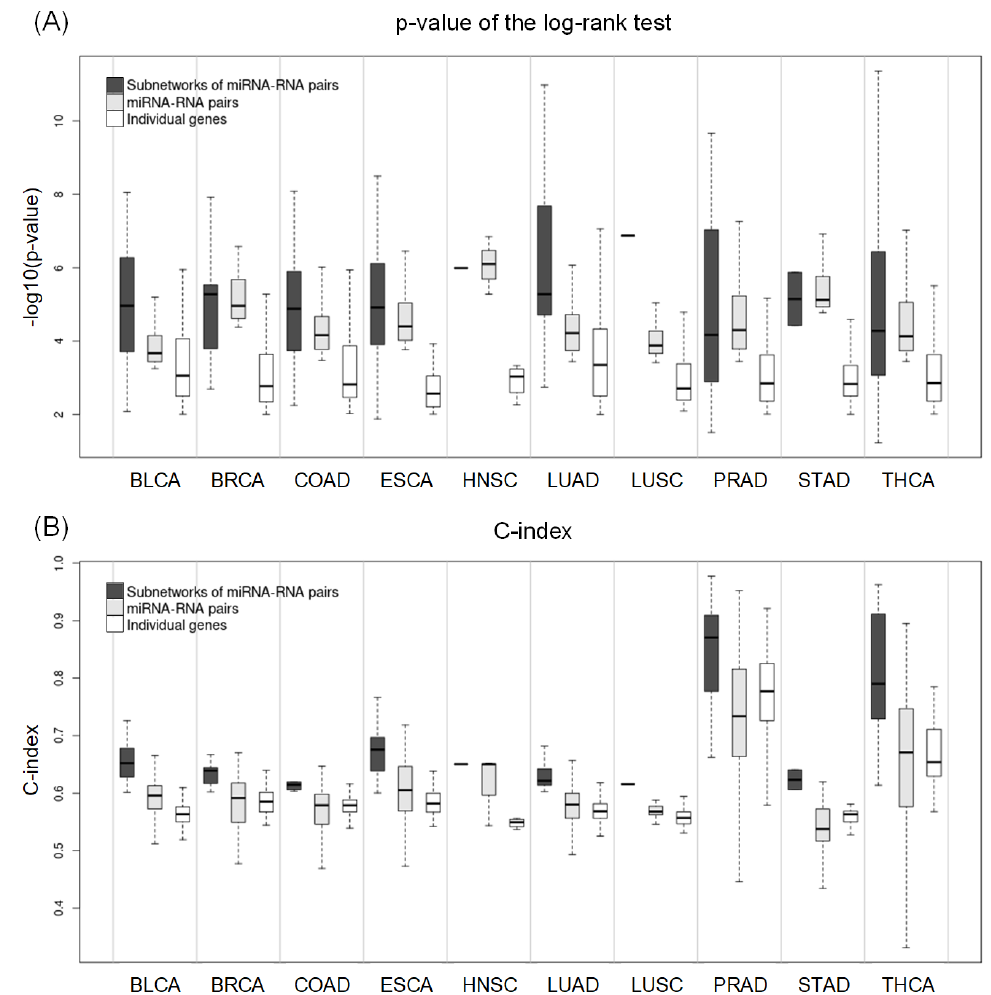
Figure 5. ( A ) Distribution of the p -values derived from the log–rank test with respect to subnetworks, miRNA–RNA pairs, and individual genes. ( B ) Distribution of the C-index values with respect to subnetworks, miRNA–RNA pairs, and individual